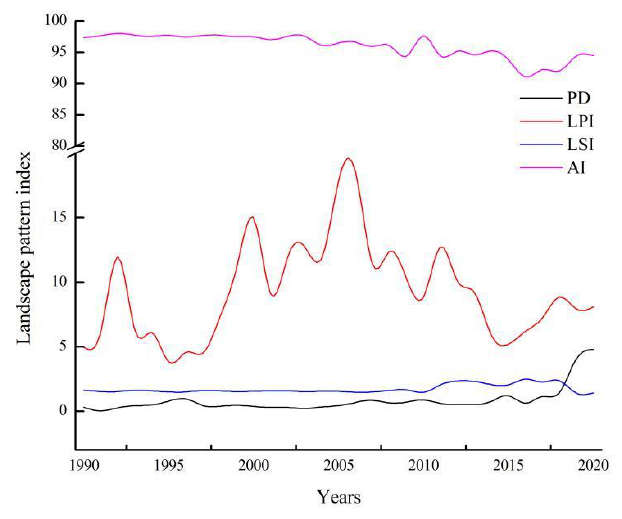
Figure 7. Landscape pattern changes for S. salsa for each year.